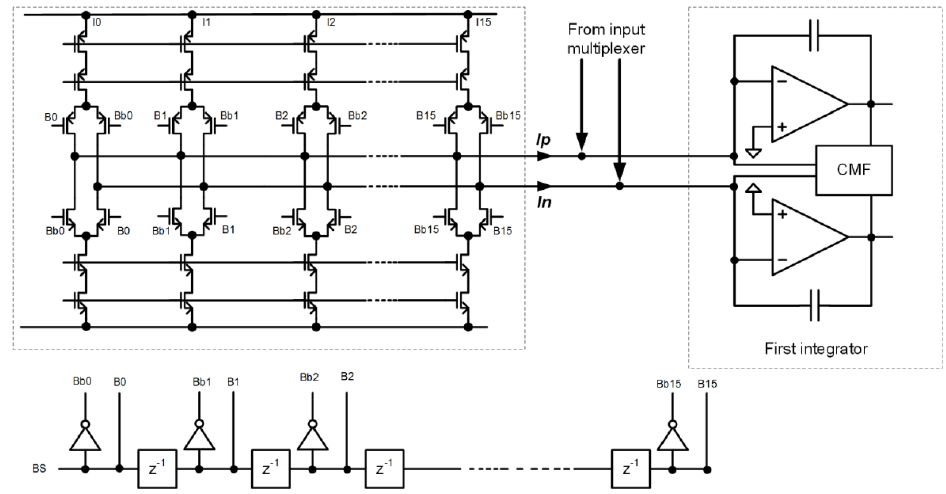
Figure 8. FIR-DAC filter implementation. The weights are implemented by current sources with different ratios. The reference current is possible to adjust to compensate inaccuracy due to